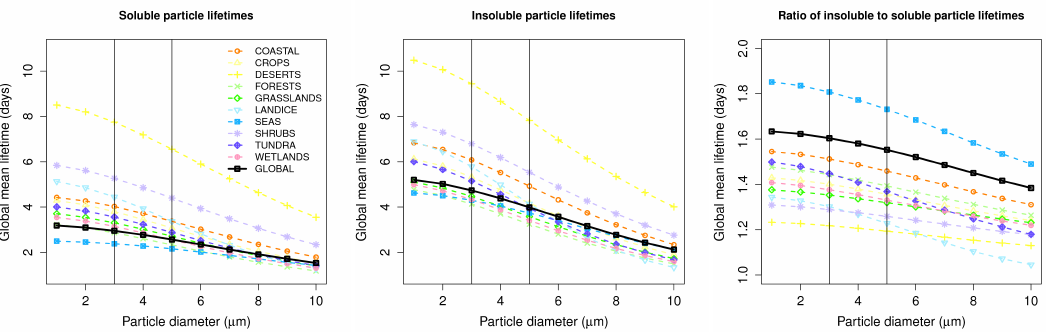
Fig. 1. Global mean residence times of 1µm particles in the BASE model setup as function of aerodynamic diameter, emission ecosystem, and CCN activity. Left panel: CCN-ACTIVE. Middle: CCN-INACTIVE. Right: ratio of CCN-INACTIVE to CCN-ACTIVE residence times. Points indicate the locations of the simulations performed. The color key is indicated in the left panel.